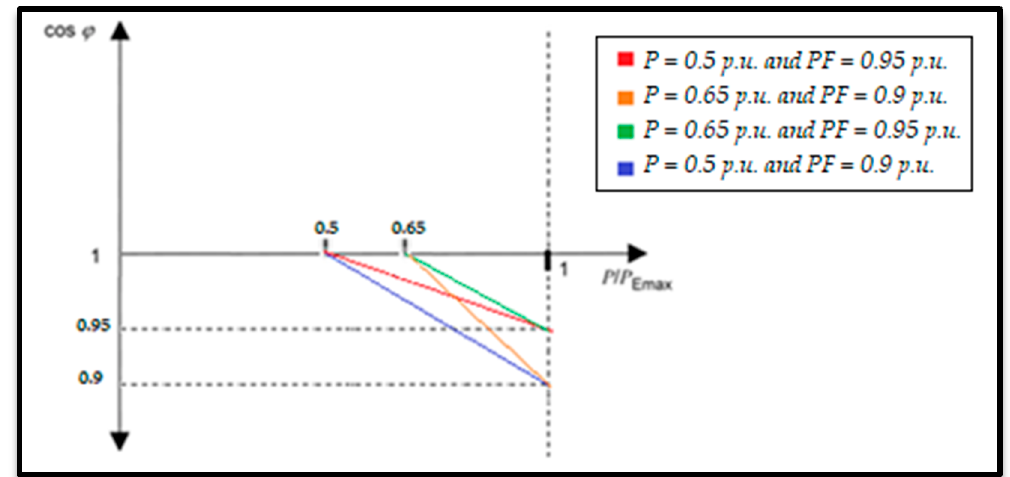
Figure 2. PF variation curve depending on the active power generated.